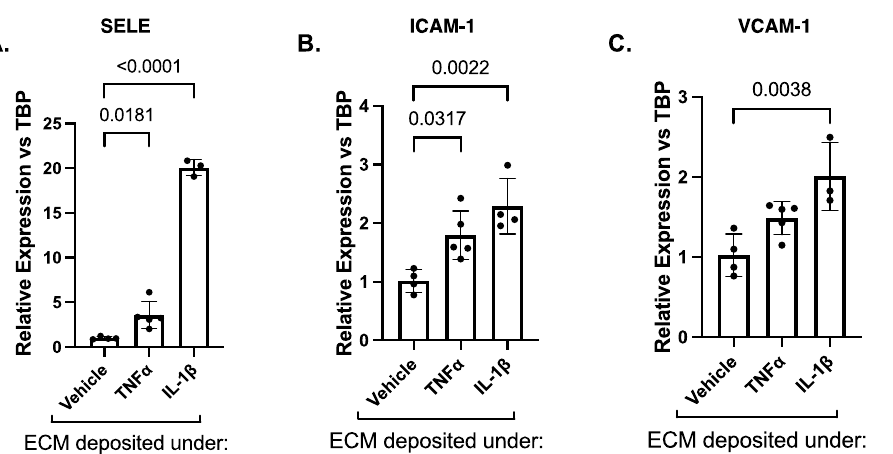
Figure 4. ECM derived from cytokine-treated hRP causes induction of hRMEC adhesion molecules. Naïve hRMEC were plated onto ECM derived from TNFα- or IL-1β-treated hRP. hRMEC were collected and assayed for expression of ( A ) E-selectin (gene name: SELE), ( B ) ICAM-1, or ( C ) VCAM-1. Expression data are reported as fold induction over vehicle with bars representing mean ± SD (vehicle: n = 4; TNFα: n = 5; IL-1β: n =